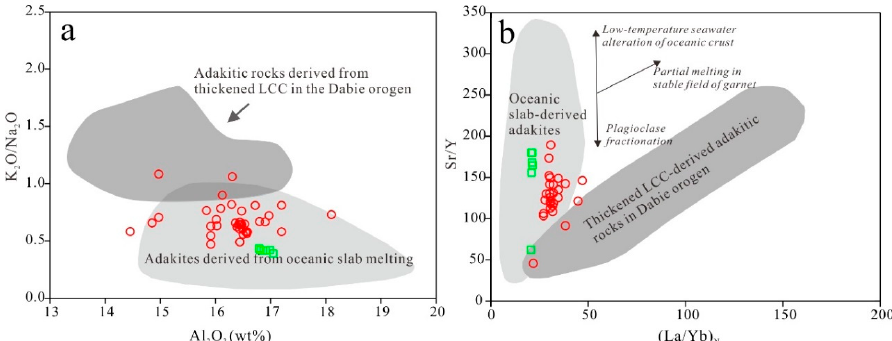
Figure 11. ( a ) K 2 O/Na 2 O vs. Al 2 O 3 diagram comparing adakites from the Yueshan–Zongpu and other localities. Field of oceanic slab-derived adakites is after [66]; whereas field of Dabie adakites from thickened LCC (lower continental crust) is from [30]; ( b ) Sr/Y vs. (La/Yb) N diagram for the Yueshan–Zongpu intrusive rocks. Modified after [30]. Symbols are as in Figure 4.